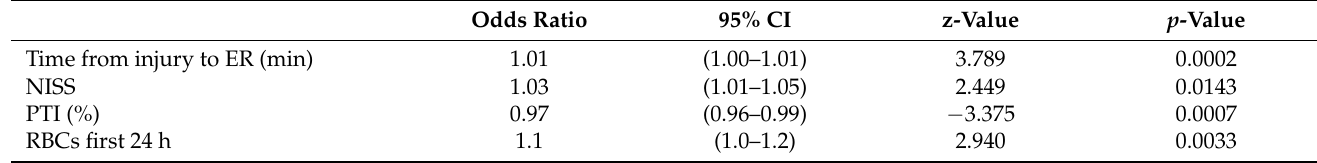
Table 4. Multivariate analysis for IL-6 values < 350 pg/dL vs. ≥ 350 pg/dL. Odds